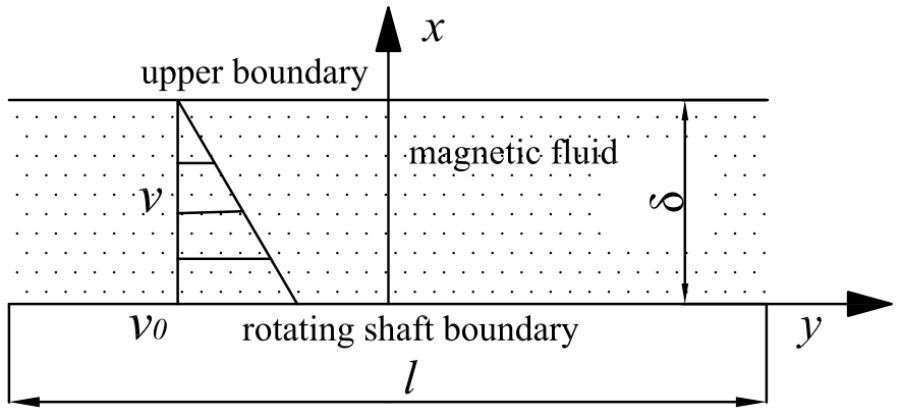
Figure 2. Two-dimensional model for temperature calculations.